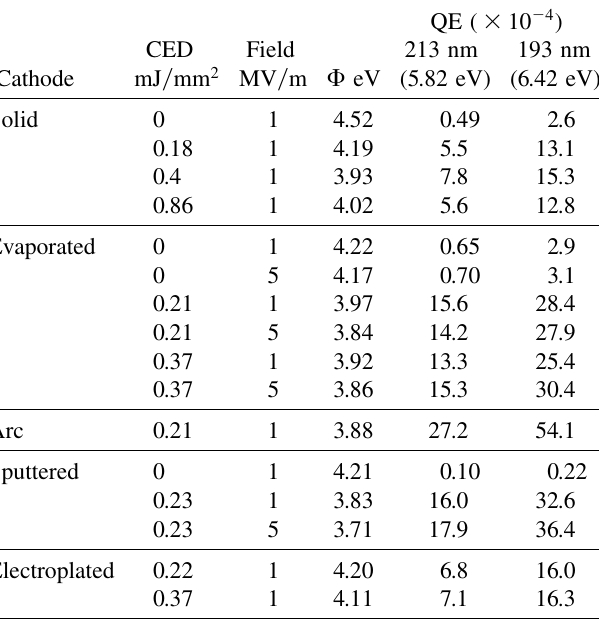
TABLE I. Work function ( (cid:1) ) and QE of cathodes, including cleaning energy density (CED) of 248 nm light used, and bias field applied between the cathode and the anode. A CED of 0 represents the value prior to laser